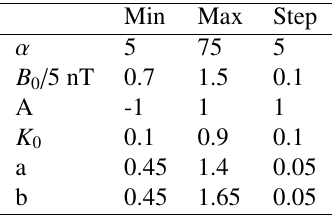
Table 1. Model parameters ranges and step used to build the proton model flux